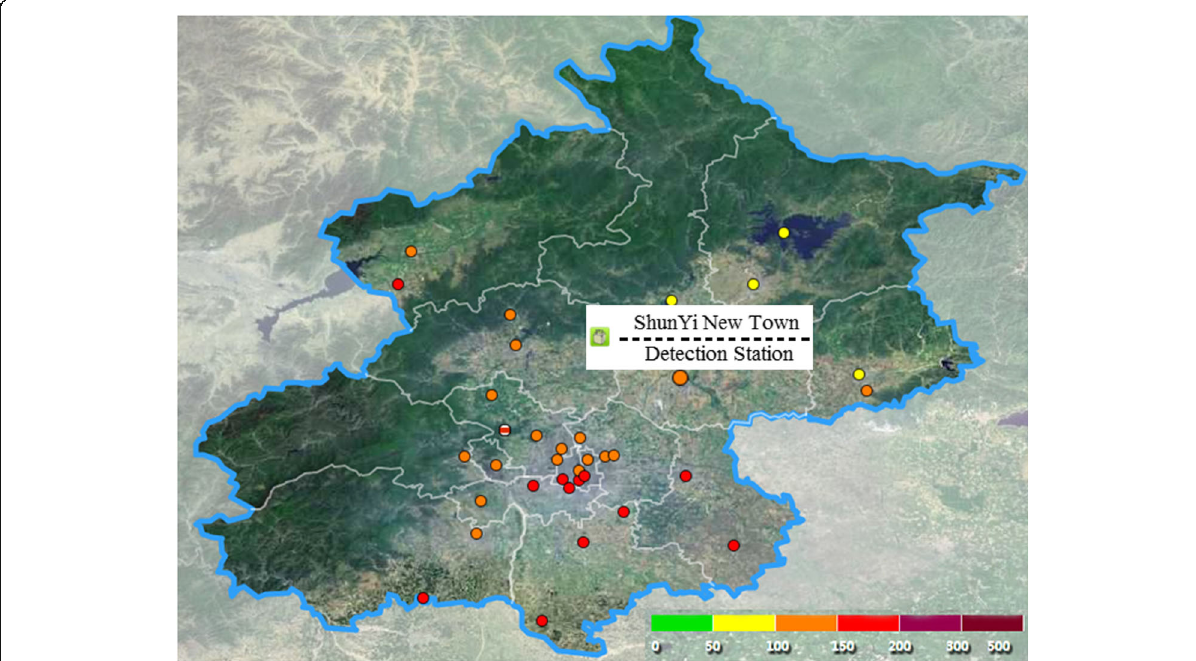
Fig. 3 Distribution of 23 air quality observation points in